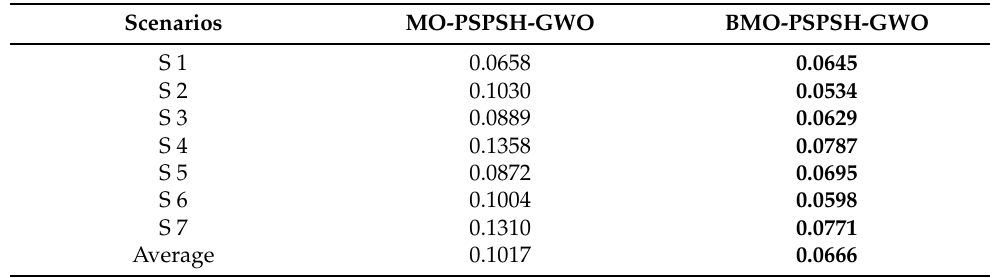
Table 8. Comparison between MO-PSPSH-GWO and BMO-PSPSH-GWO in terms of waiting time rate (WTR) reduction.